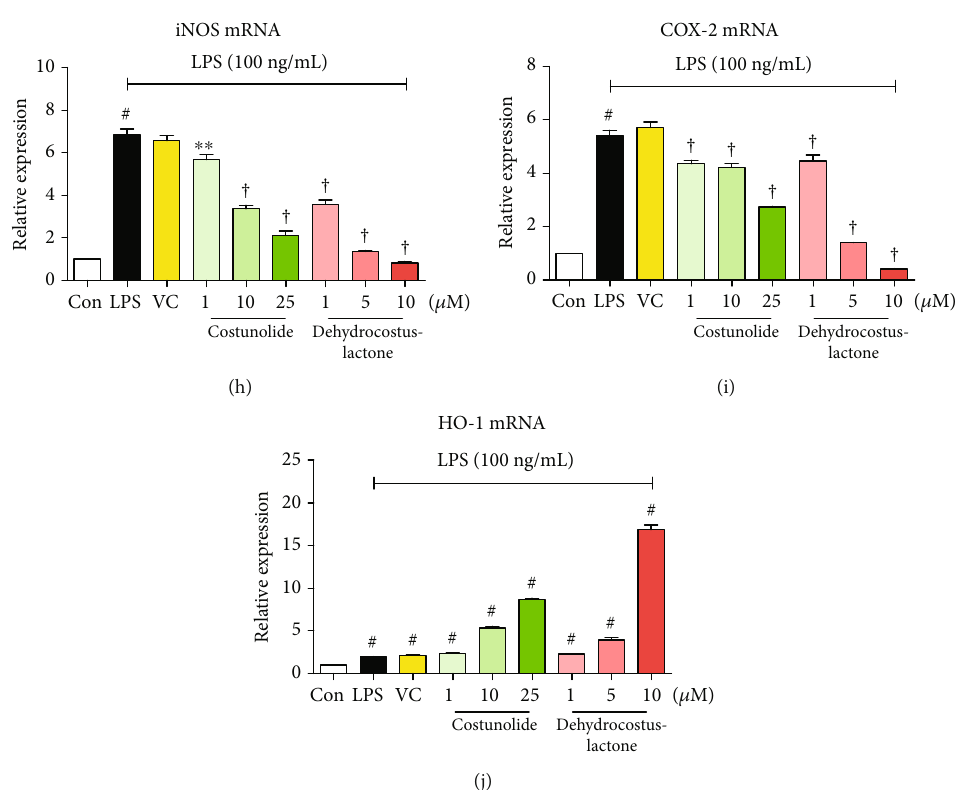
Figure 6: E ff ects of two compounds costunolide and dehydrocostuslactone on (a) viability of microglia, secretion of (b) nitric oxide (NO) and (c, d) in fl ammatory cytokines, and expression of (e – g) cytokine mRNAs, (h, i) inducible nitric oxide synthase (iNOS) and cyclooxygenase- (COX-) 2 mRNAs, and (j) heme oxygenase- (HO-) 1 mRNA. Control cells were incubated with only fresh DMEM. BV2 cells were incubated with each compound, 0.1% dimethyl sulfoxide (DMSO), or stimulated with lipopolysaccharide (LPS) for 24 (a, b), 6 (c – g), 3 (h, i), or 6 h (j). # p < 0 : 05 (vs. control); ∗ p < 0 : 05 , ∗∗ p < 0 : 01 , and † p < 0 : 001 (vs.